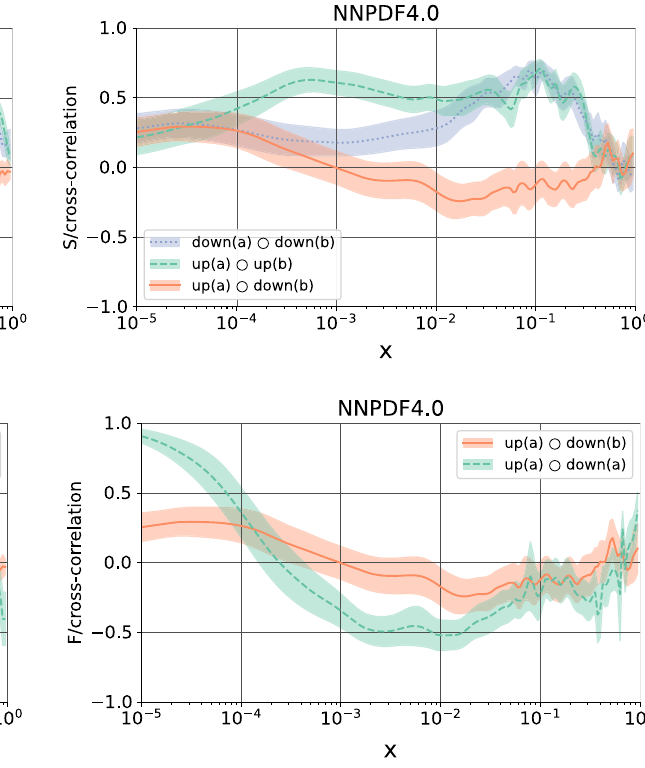
Fig. 6 Top: comparison of the the data-driven component of the S- correlation Eq. (12) of the up and down PDFs and the up-down cross- correlation Eq. (6). Bottom: comparison between the data-driven com- ponent of the up-down cross-correlation Eq. (6) and the standard F- correlation Eq. (2) for the up and down quark PDFs. Results are shown